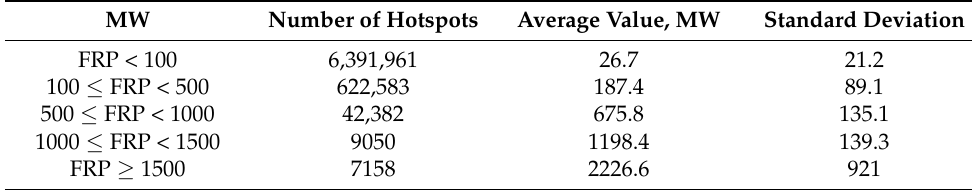
Table 1. Classification and statistics of wildfire hotspots detected in Russia during the 2001–2022 fire seasons based on FRP values.